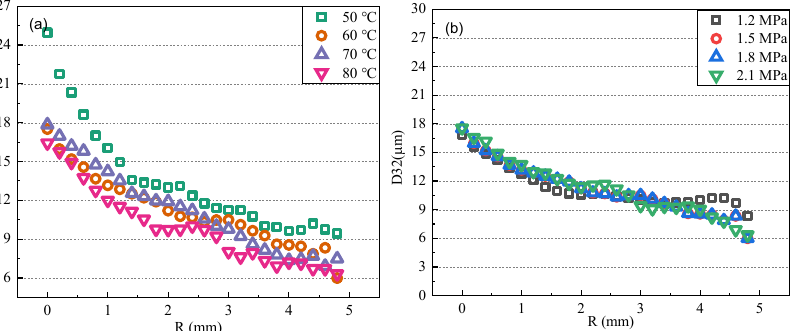
Figure 9. Effects of injection temperature and pressure on the variation of droplet D32 diameter along spray’s radial direction. ( a ) Effect of T inj on D32 variation under P inj = 1.5 MPa; ( b ) Effect of P inj on D32 variation under T inj = 60 °C.